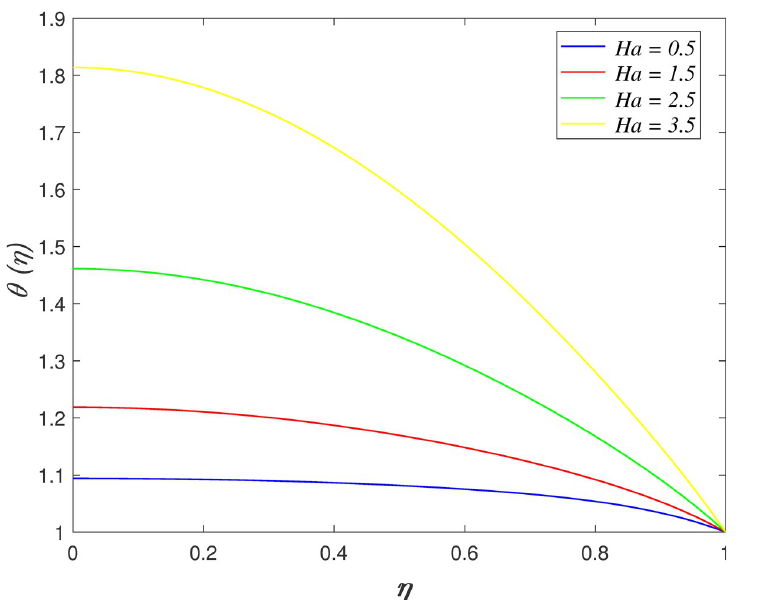
Fig 12. Impact of Ha on temperature. Fig 16 discovers the variation of Pr on temperature field. The temperature of the flow boosts with raise in Pr . Prandtl number is the ratio of momentum diffusivity and thermal diffusivity. The increment of Pr cause the heat capacity of fluid increases. It has enhanced the heat absorp- tion in the flow and thus, promotes the temperature in the fluid vicinity. The effect of Ec on